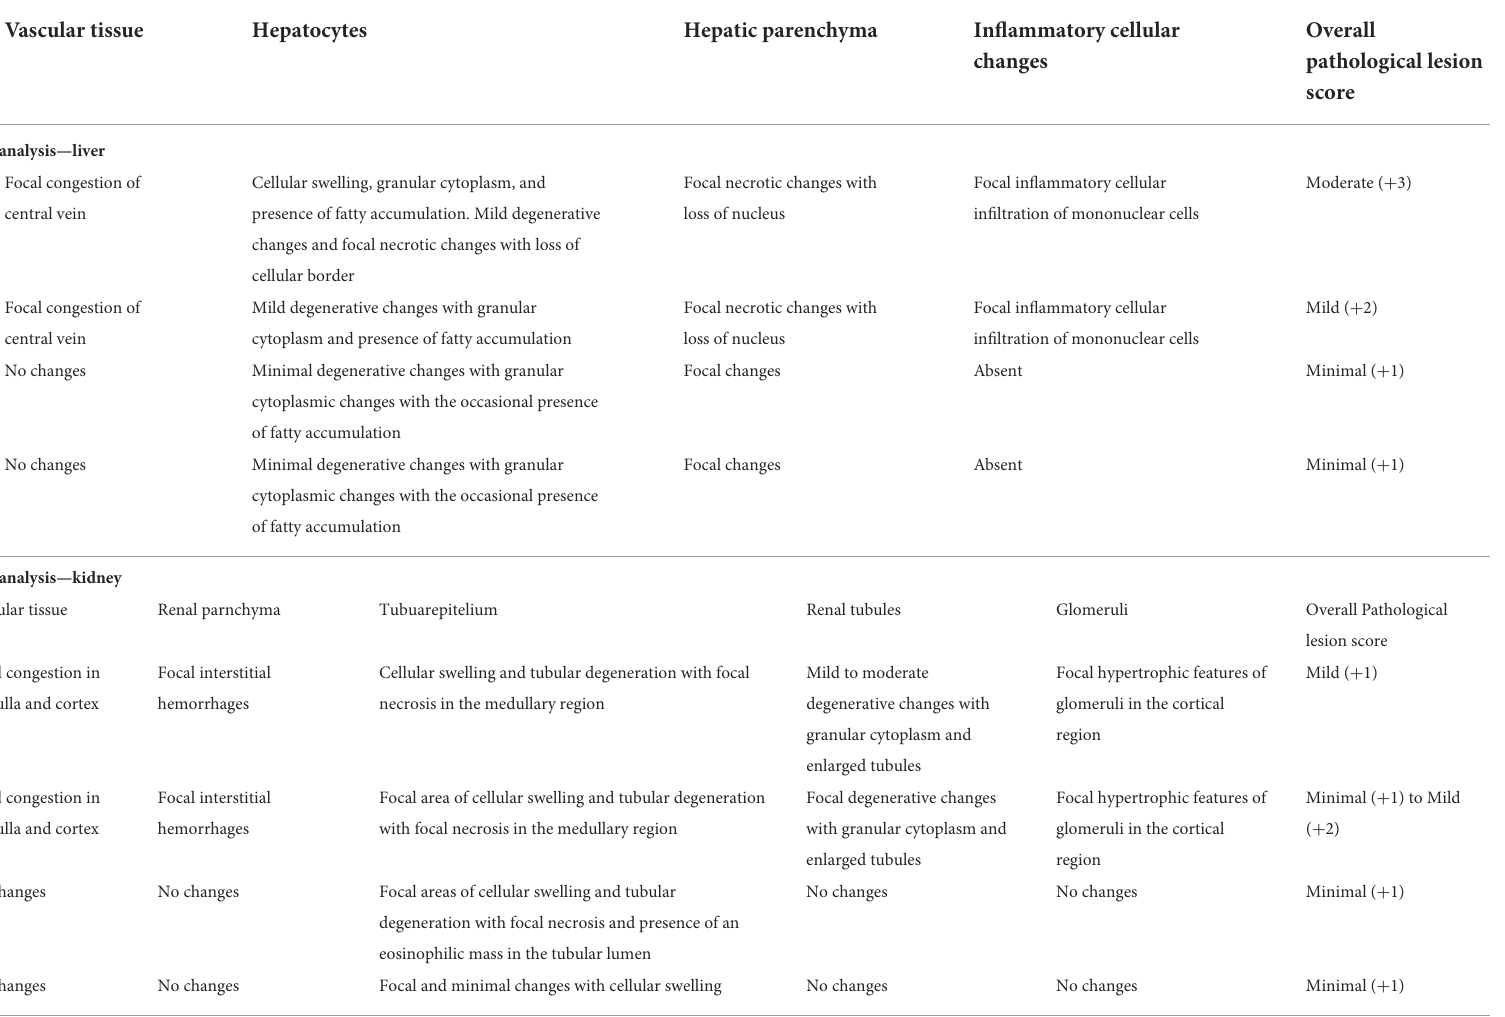
TABLE 10 Results of histopathology of